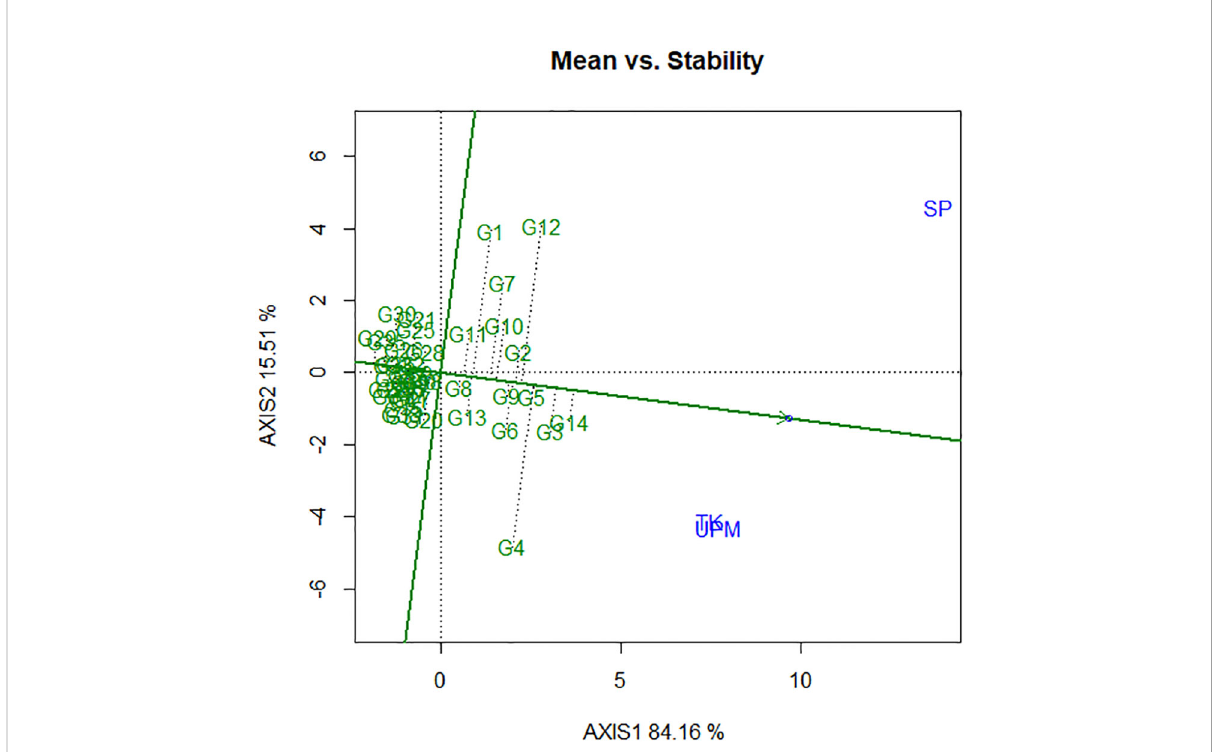
FIGURE 6 The mean vs. stability view showing the genotype main effects plus genotypic × environment interaction effect biplot (G + G × E) interaction effect of 41 rice genotypes in three locations for yield per